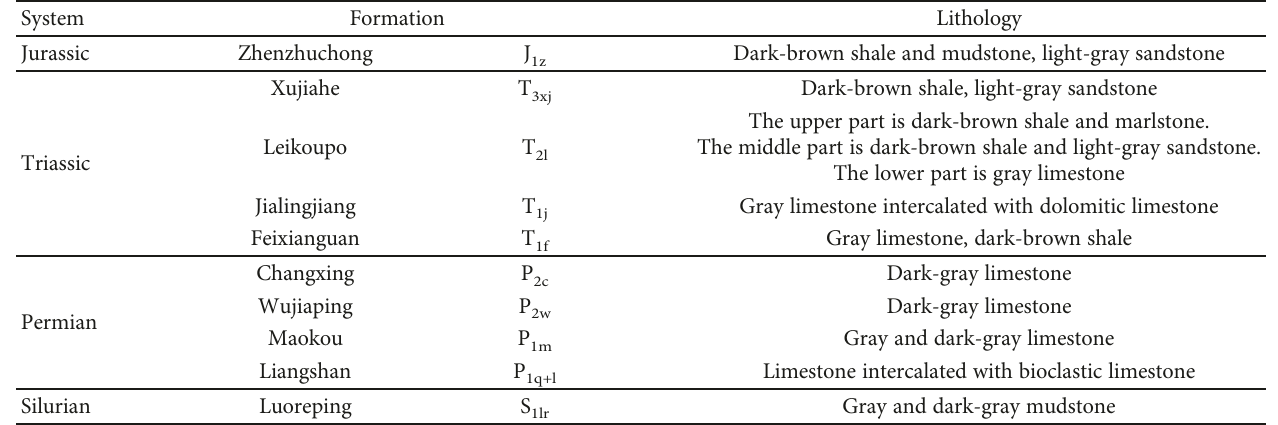
Figure 1: The location of the study area and tunnel project. Table 1: Formation lithology of the Wulong tunnel